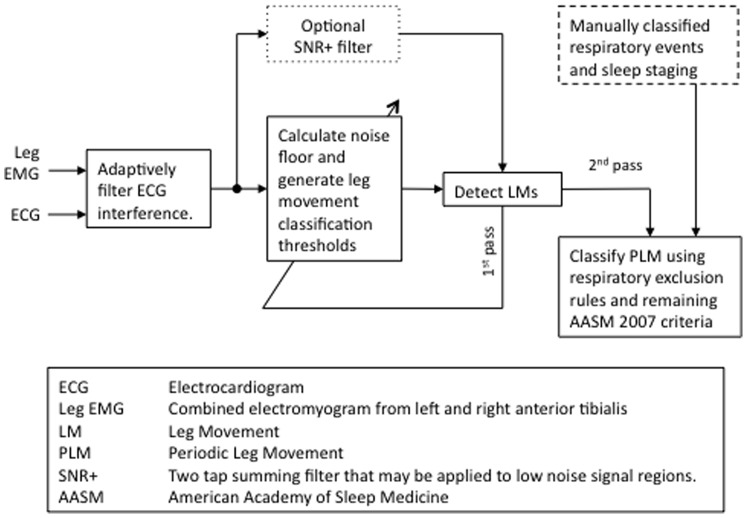
Flow chart of ten-step PLM detection algorithm.First pass LM detections are used to update the noise floor and generate the three amplitude thresholds a second time. The second pass LM detections are subsequently classified or rejected using AASM 2007 PLM scoring criteria, with our modification for respiratory exclusion.